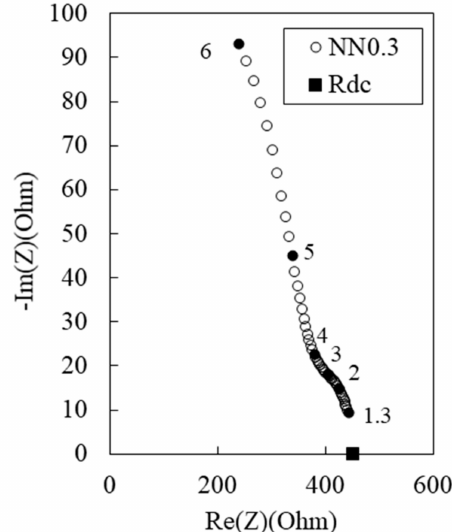
Figure 4. Experimental Nyquist plot for 100 MPa-HPCC with 0.3 wt.% MWCNT (length: 50–150 µ m, diameter: 6–9